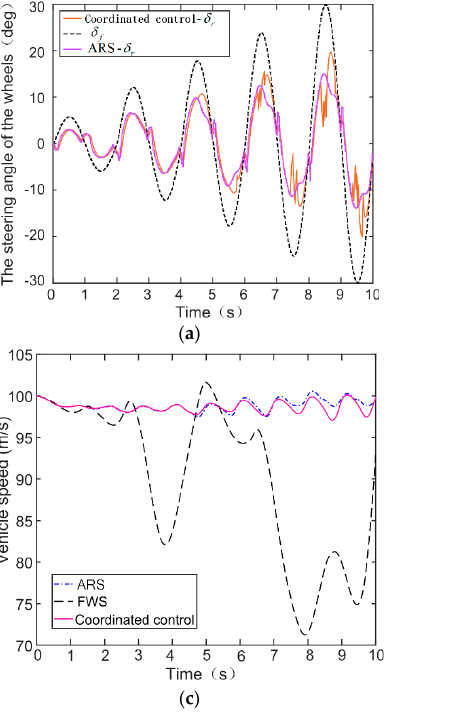
Table 12. Setting of test conditions.